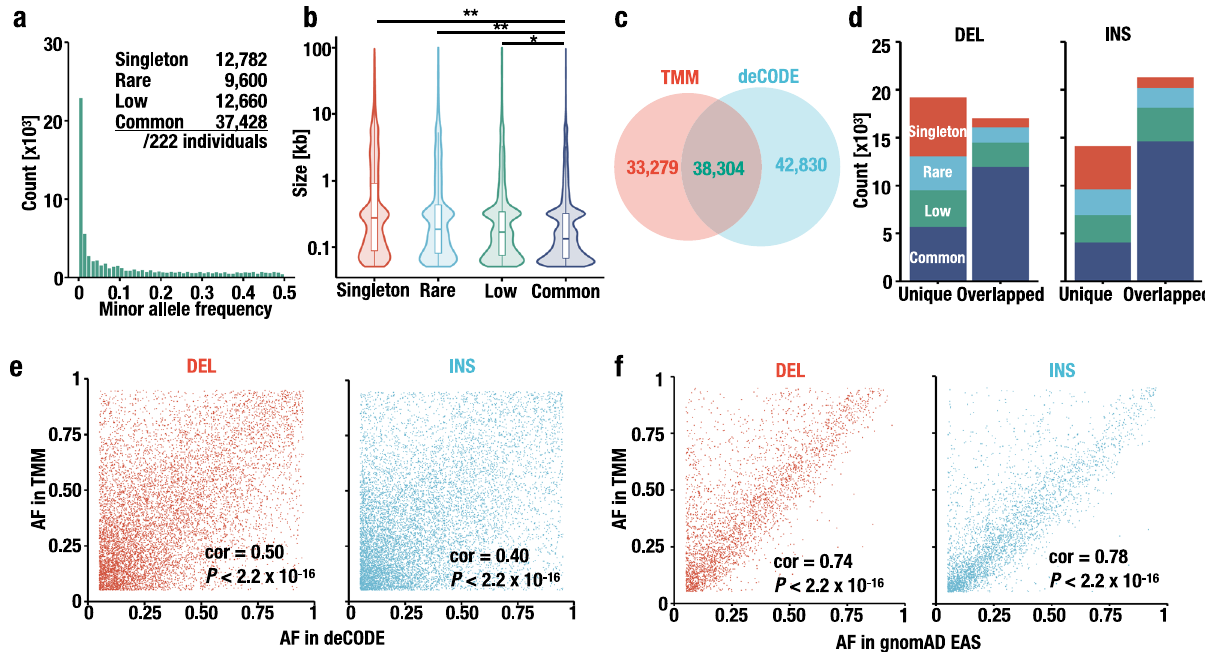
Fig. 3 Characteristics of SVs detected in the Japanese population. a Distribution of minor allele frequency (MAF). SVs were categorized as follows: singleton (minor allele count [MAC] = 1), rare (MAC > 1 and MAF < 1%), low (MAF ≥ 1% but <5%), and common (MAF ≥ 5%). b Distribution of the SV size in each MAF category. * P = 0.00098 and ** P < 2 × 10 − 16 , Holm adjusted Wilcoxon rank-sum test. The numbers of SVs belonging to each category are shown in Fig. 3a. Each boxplot has a box that represents the interquartile range (IQR) and whiskers that extend 1.5 × IQR from the box edges. The median is shown in a horizontal line in the box. c Overlap between our dataset and a previous report 35 . The numbers of SVs identi fi ed in this work (TMM), and previous work (deCODE) are shown in red and blue, respectively. The number of SVs identi fi ed in both studies is shown in green. d Bar plot showing the proportion of MAF categories in DELs (left) and INSs (right) identi fi ed in the TMM dataset only (unique) and in both the TMM and deCODE datasets (overlapped). e Scatterplot showing the allele frequencies estimated in the deCODE study ( x axis) and this study ( y axis). The Pearson correlation coef fi cient (cor) and P values are shown. n = 8568 and 9762 for DEL and INS, respectively. f Scatterplot showing the allele frequencies estimated in the East Asian subset of the gnomAD study ( x axis) and this study ( y axis). The Pearson correlation coef fi cient (cor) and P values are shown. n = 3491 and 3515 for DEL and INS,